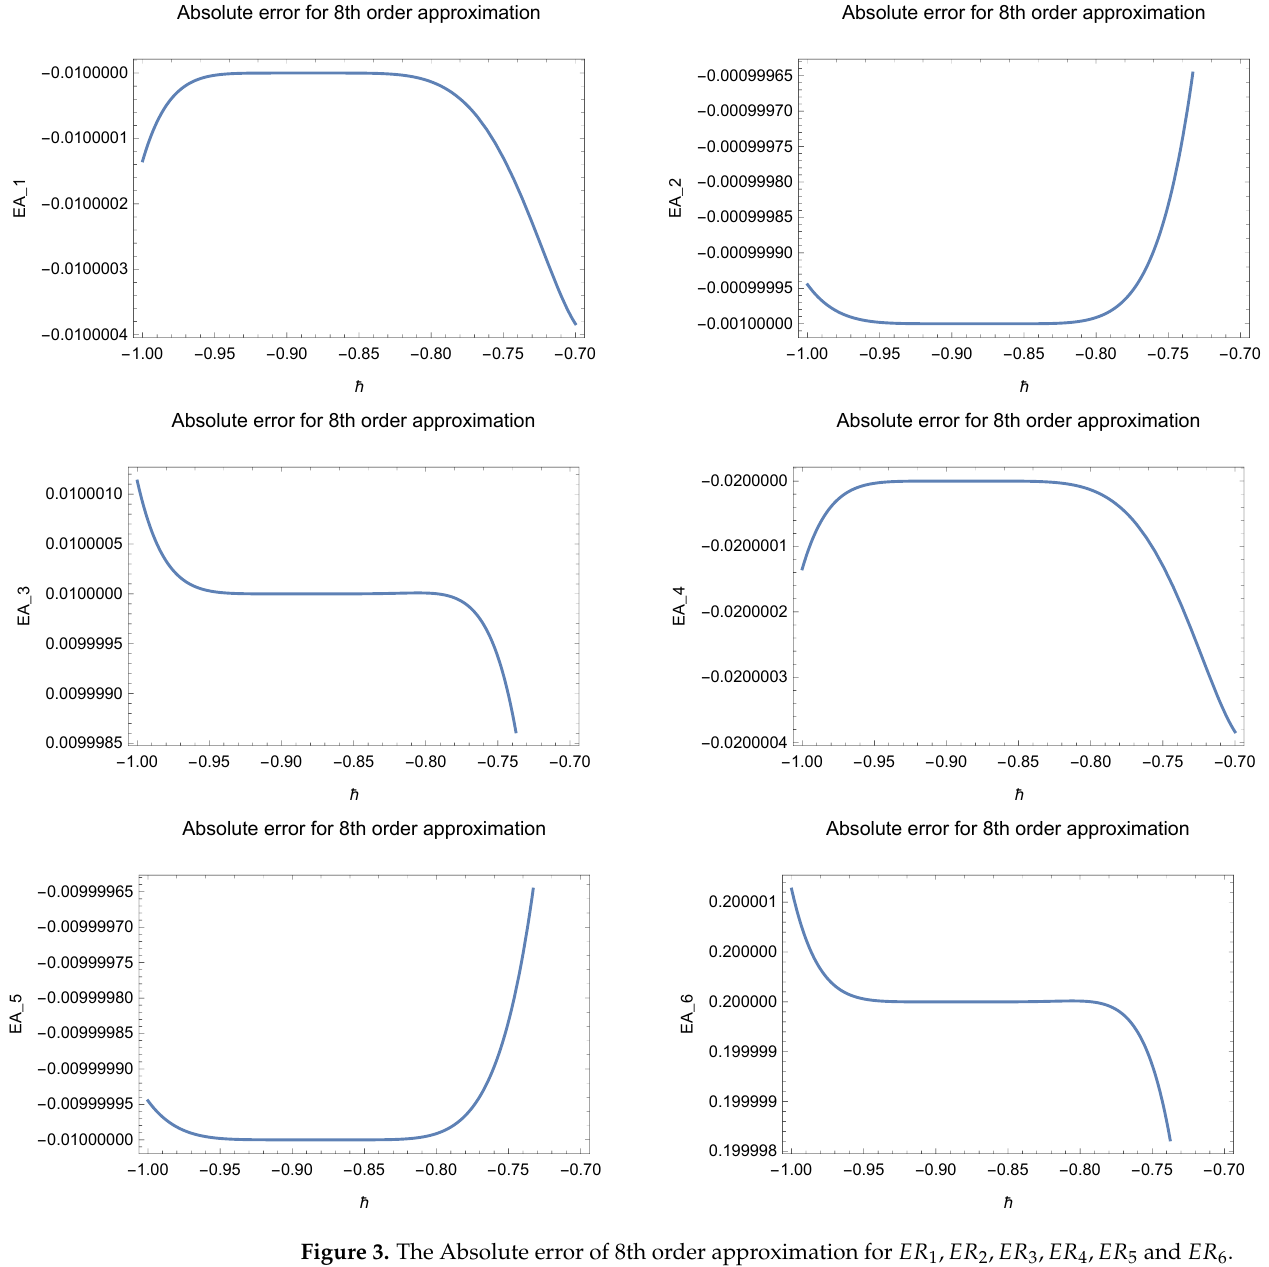
Figure 3. The Absolute error of 8th order approximation for ER 1 , ER 2 , ER 3 , ER 4 , ER 5 and ER 6 Fig. 3 The Absolute error of 8 th order approximation for ER 1 , ER 2 , ER 3 , ER 4 , ER 5 and ER 6